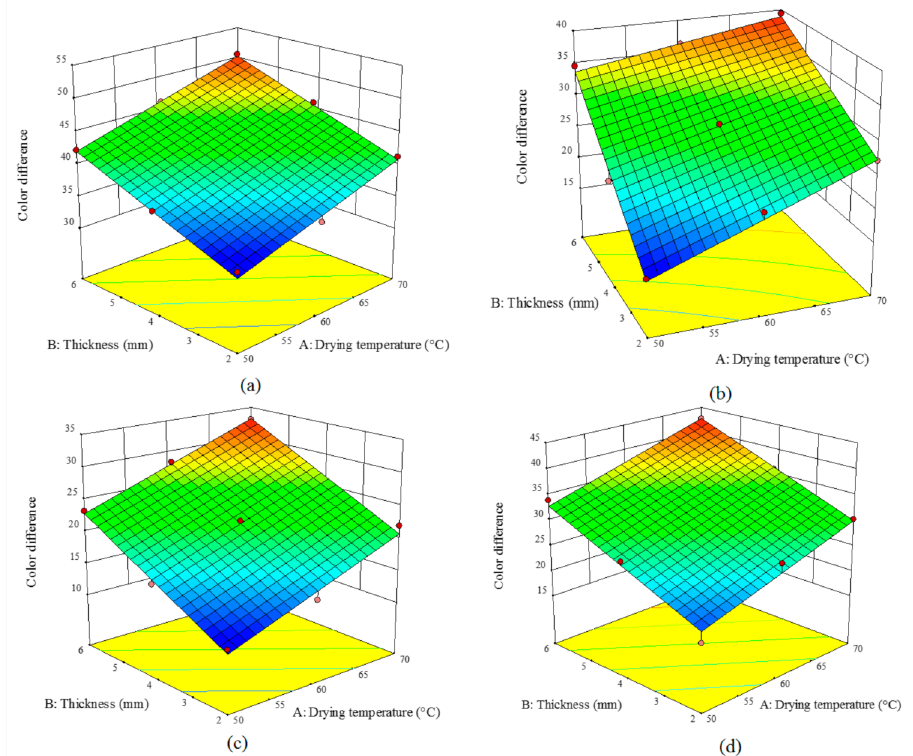
Figure 7. Effect of the drying temperature and sample thickness on the color difference of the turnip slices dried under an HCIR dryer with various pretreatments ( a ) control, ( b ) microwave, ( c ) ultrasound, and ( d )